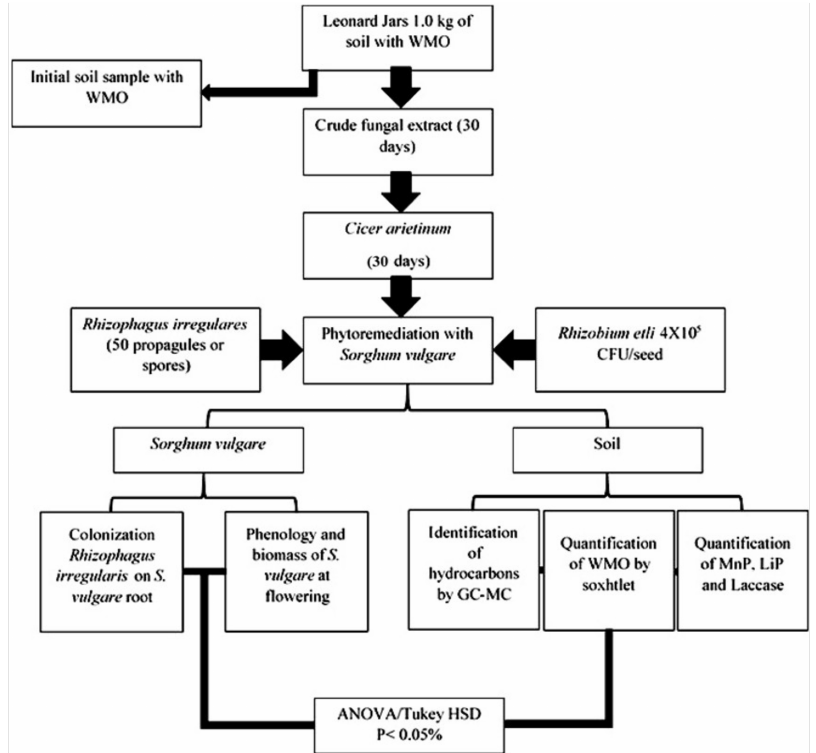
Figure 10. Experimental design of biostimulation of agricultural soil impacted by WMO applied crude fungal extract then with C. arietinum and phytoremediation of remaining of 34,500 ppm of WMO by Sorghum vulgare inoculated with Rhizophagus irregularis and/or Rhizobium etli. Notes: WMO = waste motor oil; GC-MC = gas chromatography coupled to mass; LiP = lignin peroxidase; MnP = manganese peroxidase; CFU = colony forming